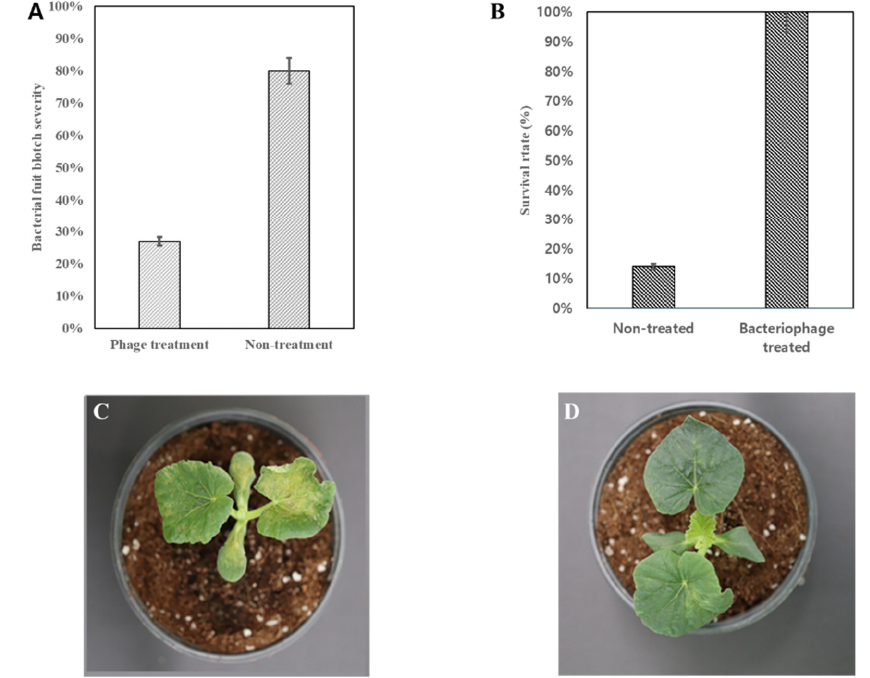
Figure 4. Effect of bacteriophage ACPWH against BFB on melon plants. BFB was induced by artificial